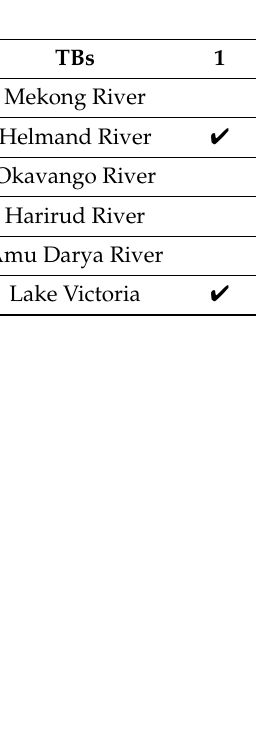
Table 3. Potential HSAs in some TBs diagnosed based on Table 2. (cid:52) a: Included in the TB. HDs Number Presented in Table